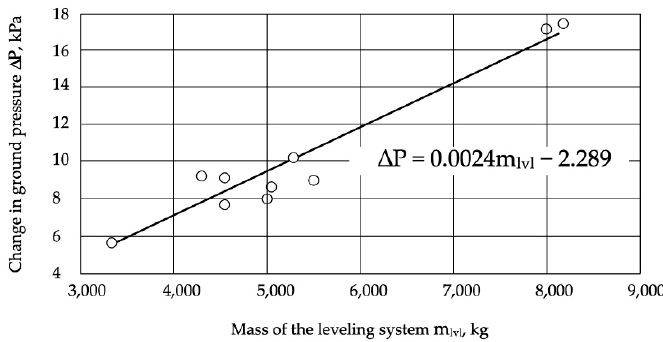
Figure 8. Diagram of the change in ground pressure vs. the weight of the leveling system. Table 1. Comparative technical characteristics of tracked feller-bunchers of one model line with and without platform leveling system [29–37]. Max. Angle of Max. Angle of Max. Angle of Mass, Platform Tilting Platform Tilting Platform Tilting Company Model kg Sideways, deg. Back, deg. Forward, deg.